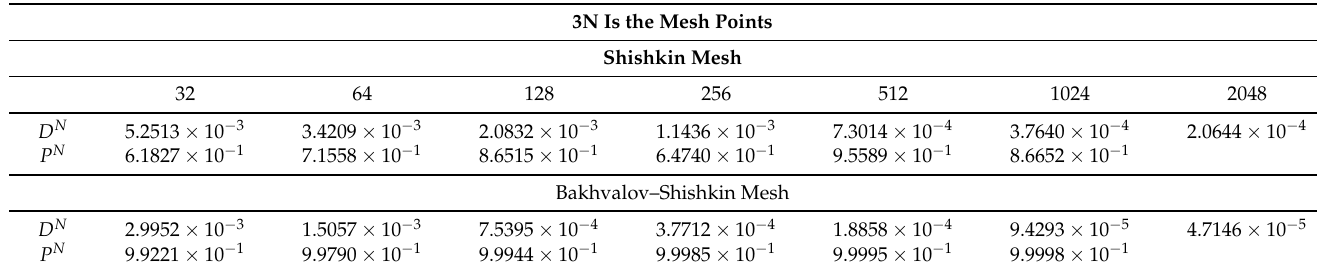
Table 1. Derived ε -uniform errors D N and orders of convergence P N for Example 1.